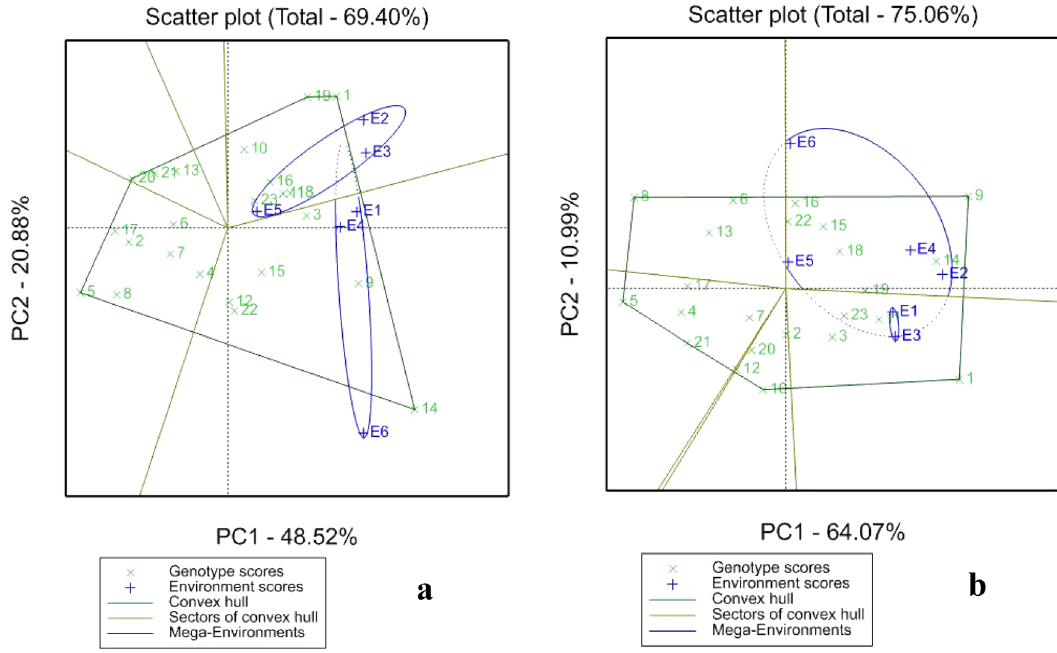
Figure 3. Outstanding performances of the sweetpotato clones for harvest index in the different environments (“which won where”) and the delineated mega environments under drought ( a ) and under well-watered ( b ) conditions.